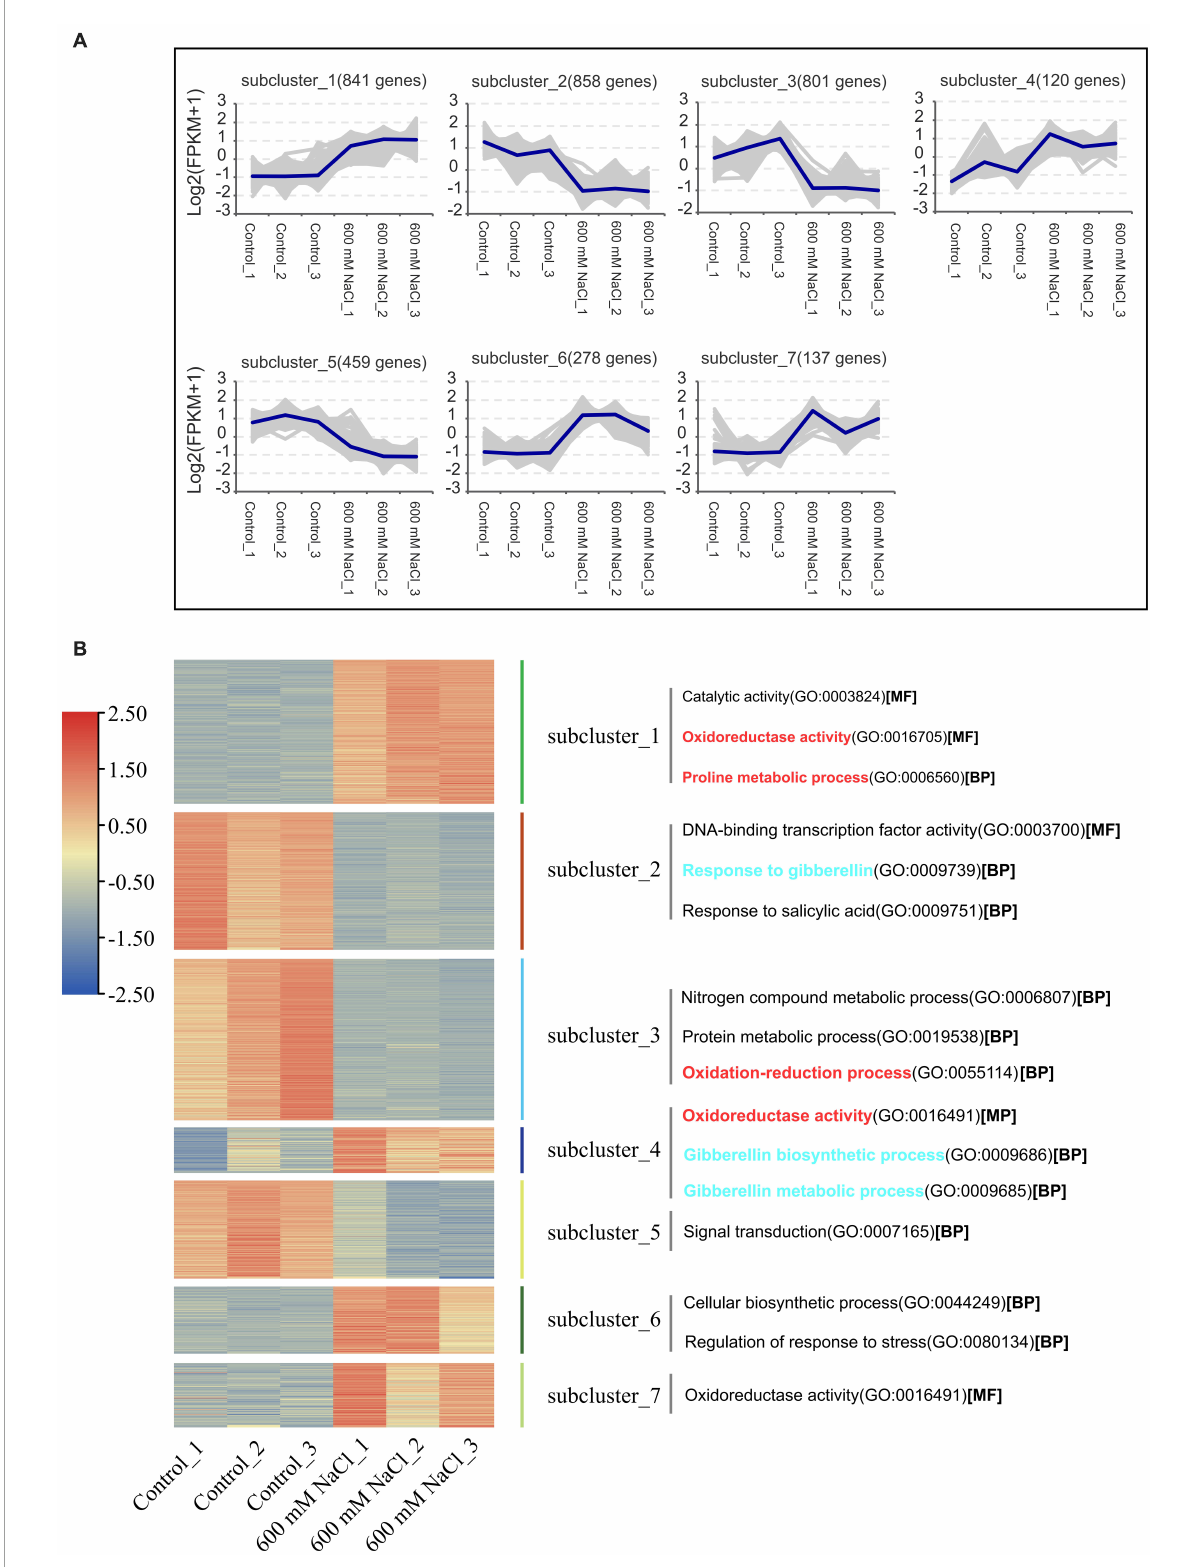
FIGURE5 Gene co-expression clusters (A) and heatmap analysis (B) of DEGs in the leaves of S. portulacastrum under high